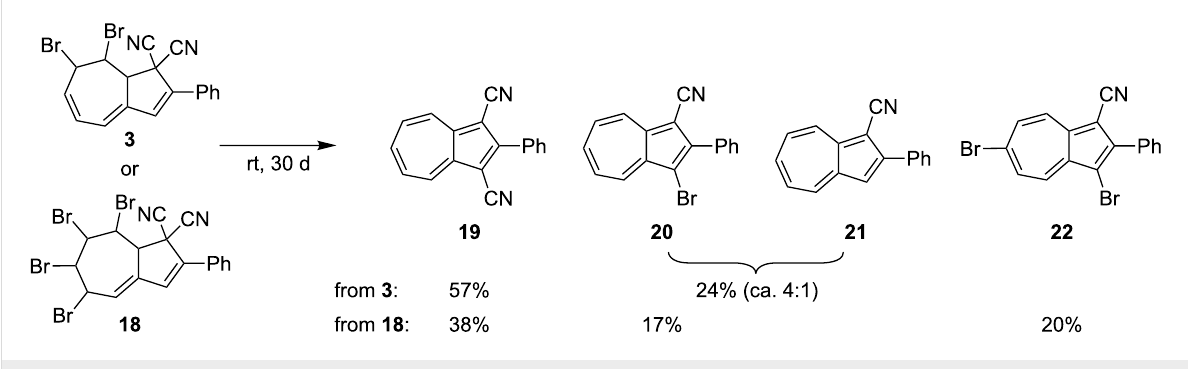
Scheme 8: Slow conversions to azulenes in the solid state.